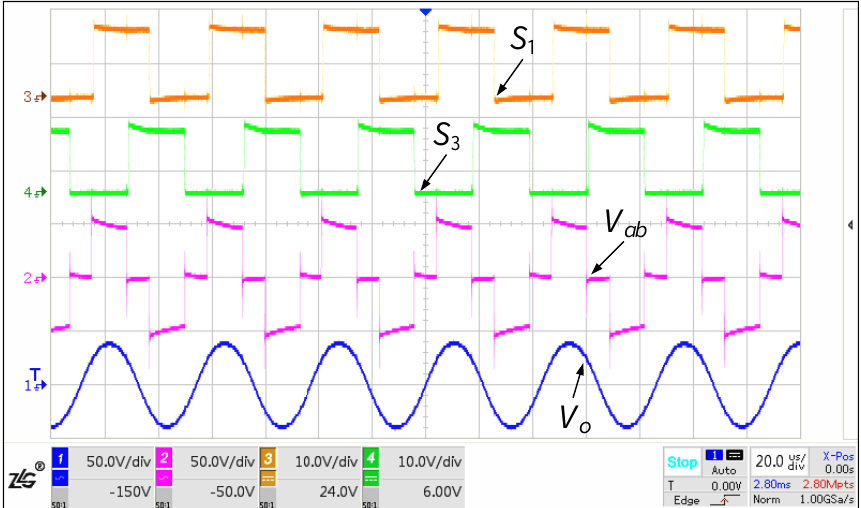
Figure 16. Experimental waveforms of the output voltage V o , output bridge arm voltage V ab , power switching driving signals S 1 and S 3 .